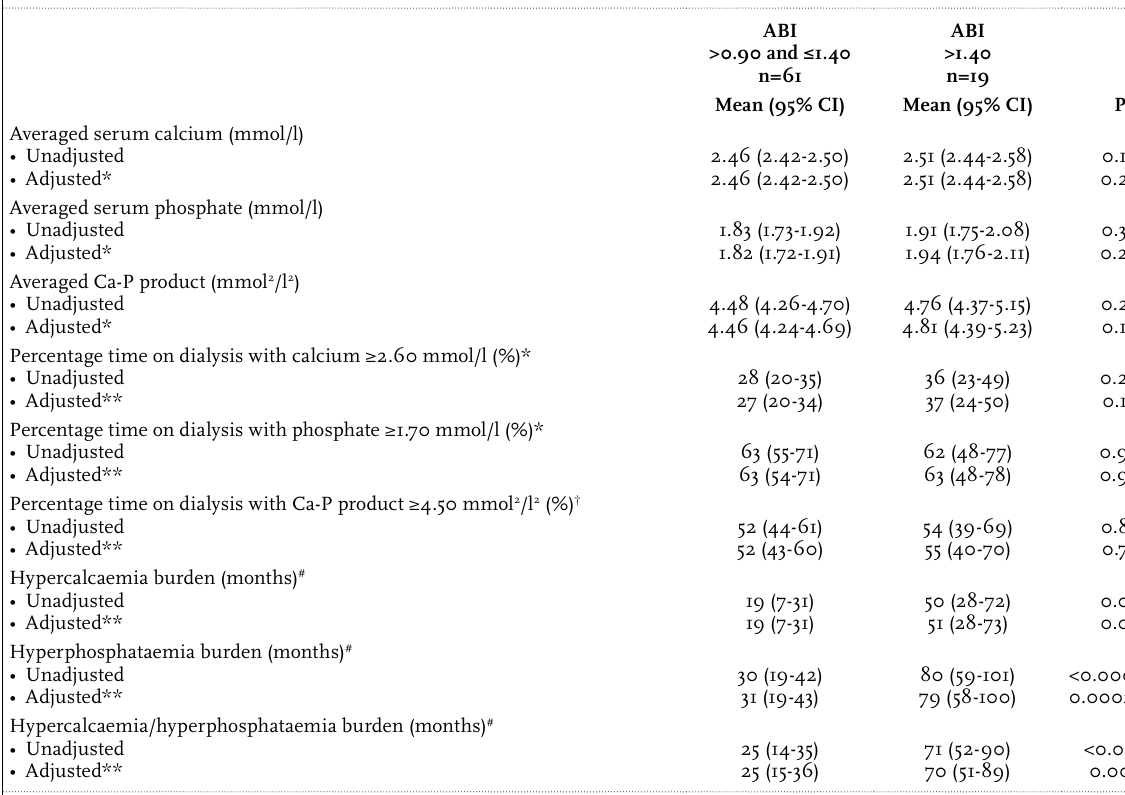
table 4. Calcium and phosphate parameters for different categories of ABI